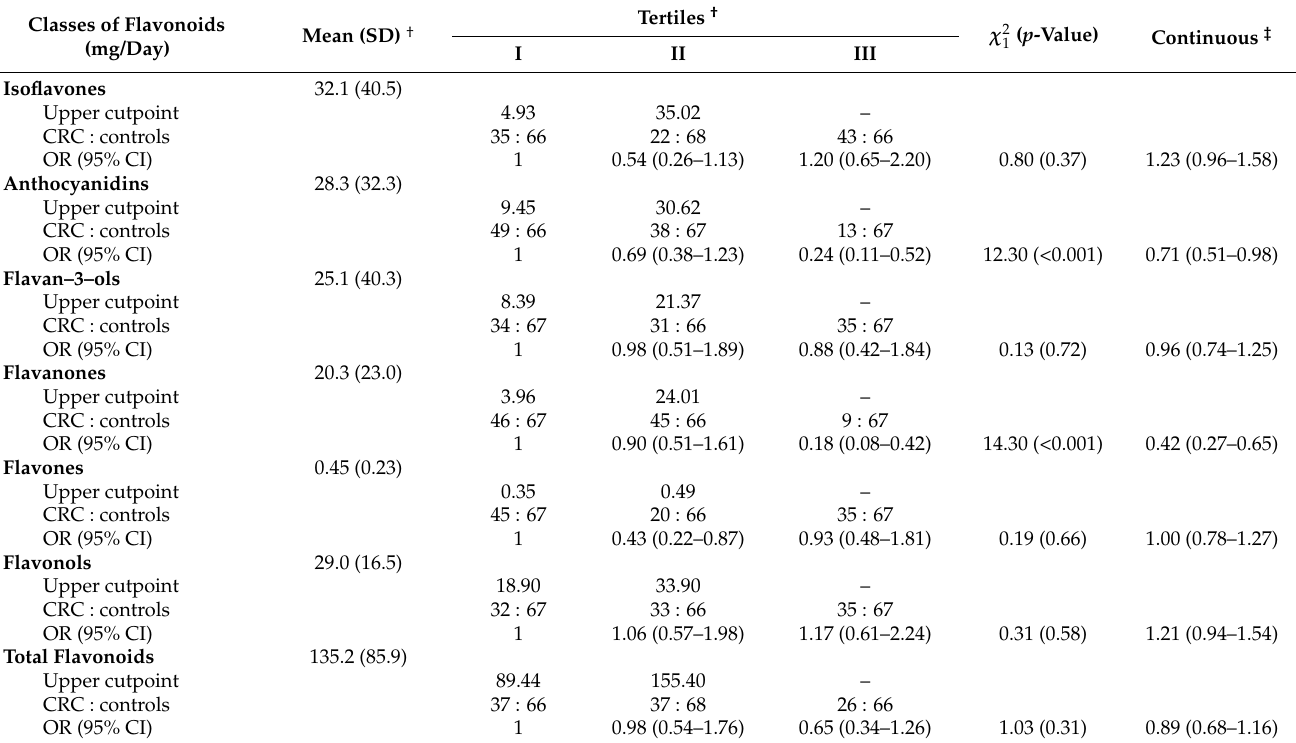
Table 2. Odds ratios (OR) * of colorectal cancer and 95% confidence intervals (CI) for flavonoid intakes among 100 cases and 200 controls. Italy 2017–2019.